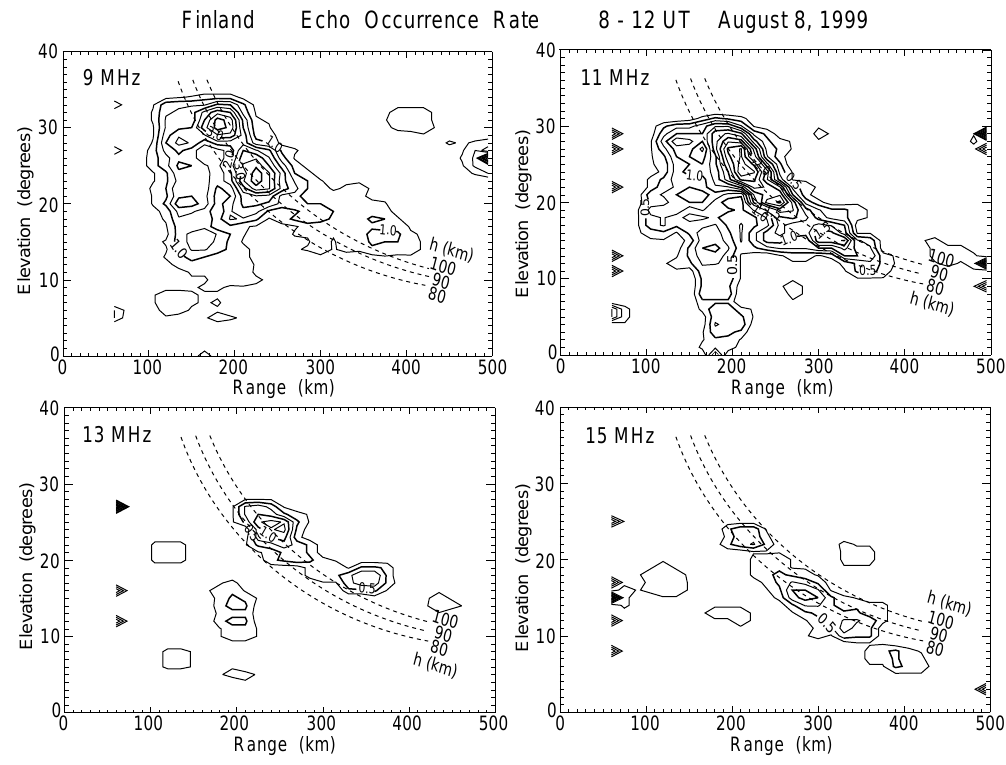
Fig. 5. Contour maps of echo occurrence rate at four frequencies as a function of range and elevation angle. Contour lines have intervals of 0.5 for 9 MHz and 0.25 for other frequencies. Relation between range and elevation angle for constant altitude ( h = 80, 90 and 100 km) is represented by dashed